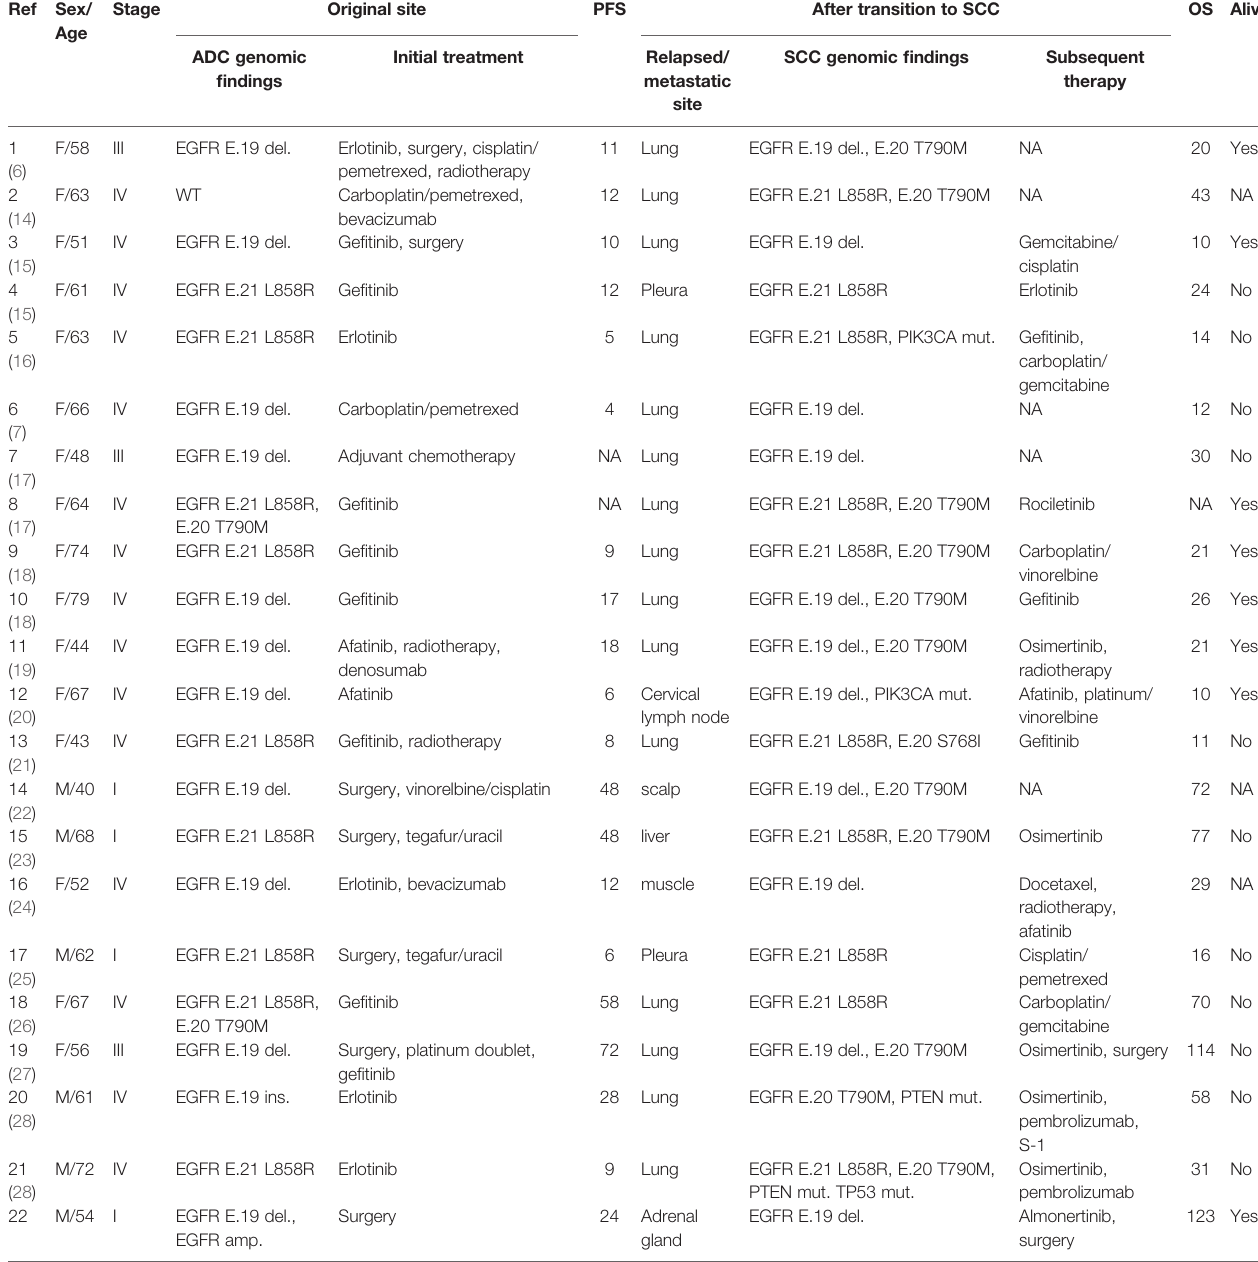
TABLE 1 | Characteristics of patients with transition to SCC from primary lung ADC after EGFR-TKIs